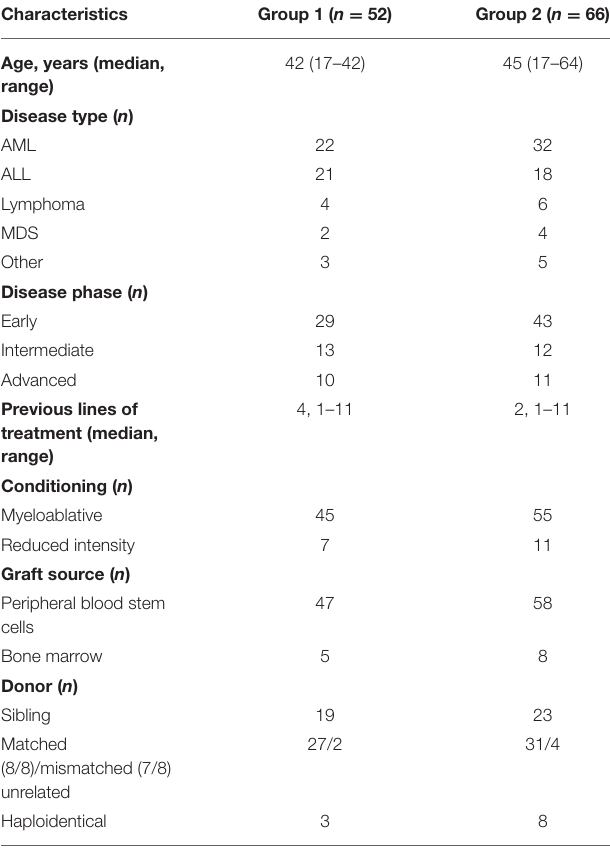
TABLE 1 | Patients’ pre-transplant characteristics.